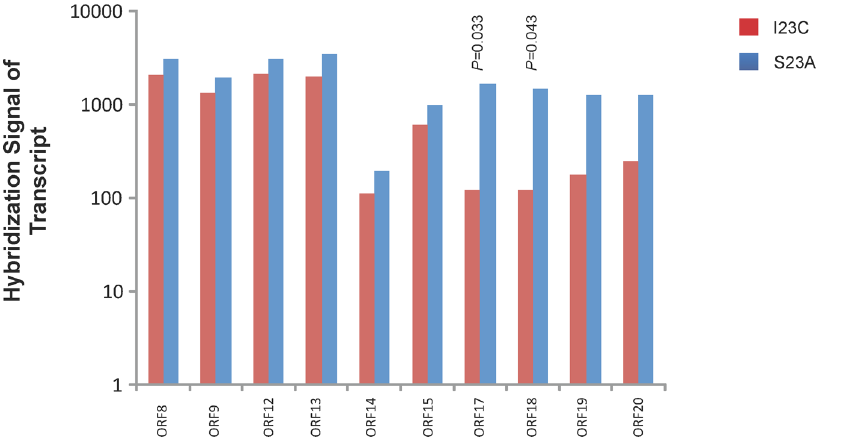
Figure 3. Hybridization signals of transcripts of SSP gene cluster in serotype-b expressing strain S23A and non-expressing strain I23C. Each bar represents mean signal of three biological replicates. Student’s t-test was performed to compare the signals between strains. The low expression levels of ORF17 and ORF18 in I23C could be explained by the 353-bp inversion that affected these two genes in I23C. In contrast, the SSP gene cluster appeared to be intact in S23AS. Note that the two downstream ORF19 and ORF20 also showed decreased levels of expression in I23C but were not statistically significantly different.